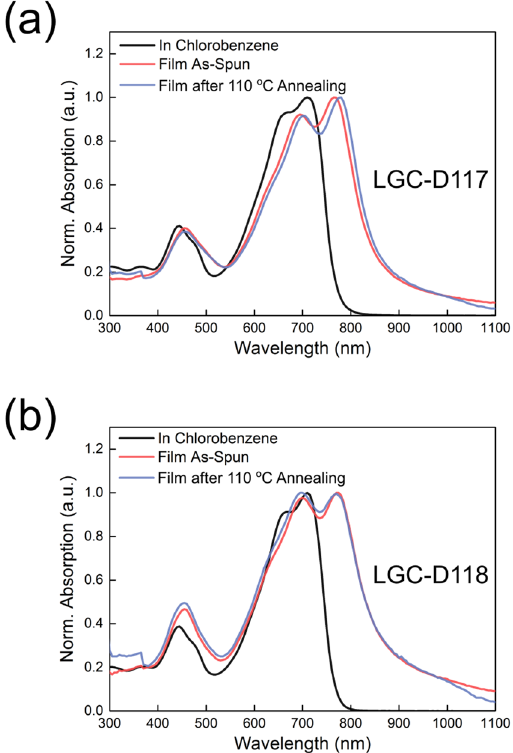
Figure 2. UV-vis absorption spectra of ( a ) LGC-D117, ( b ) LGC-D118 solutions and